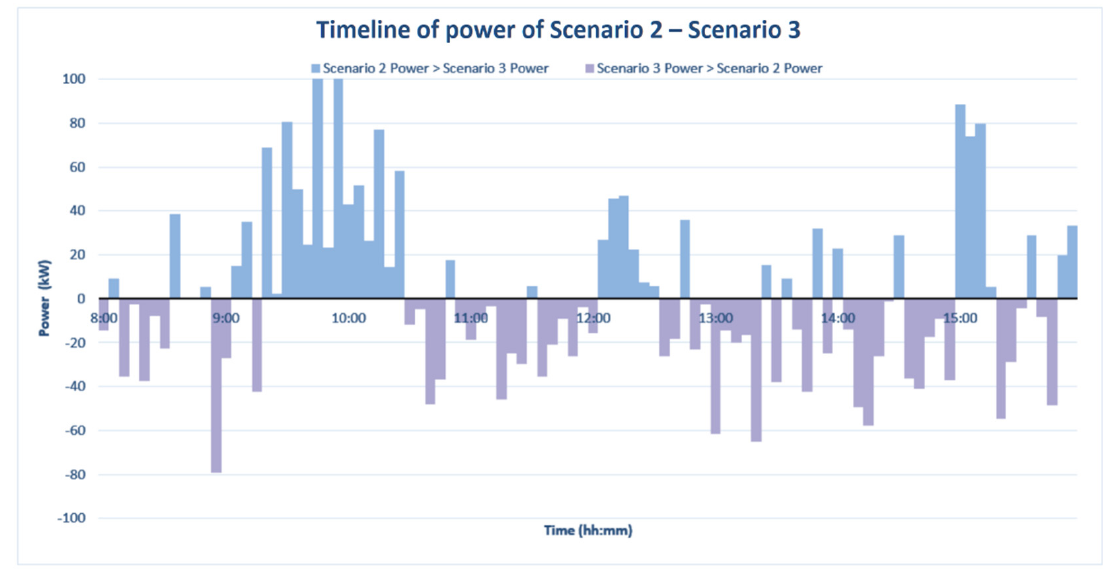
Figure 11. Scenario 2 vs. Scenario